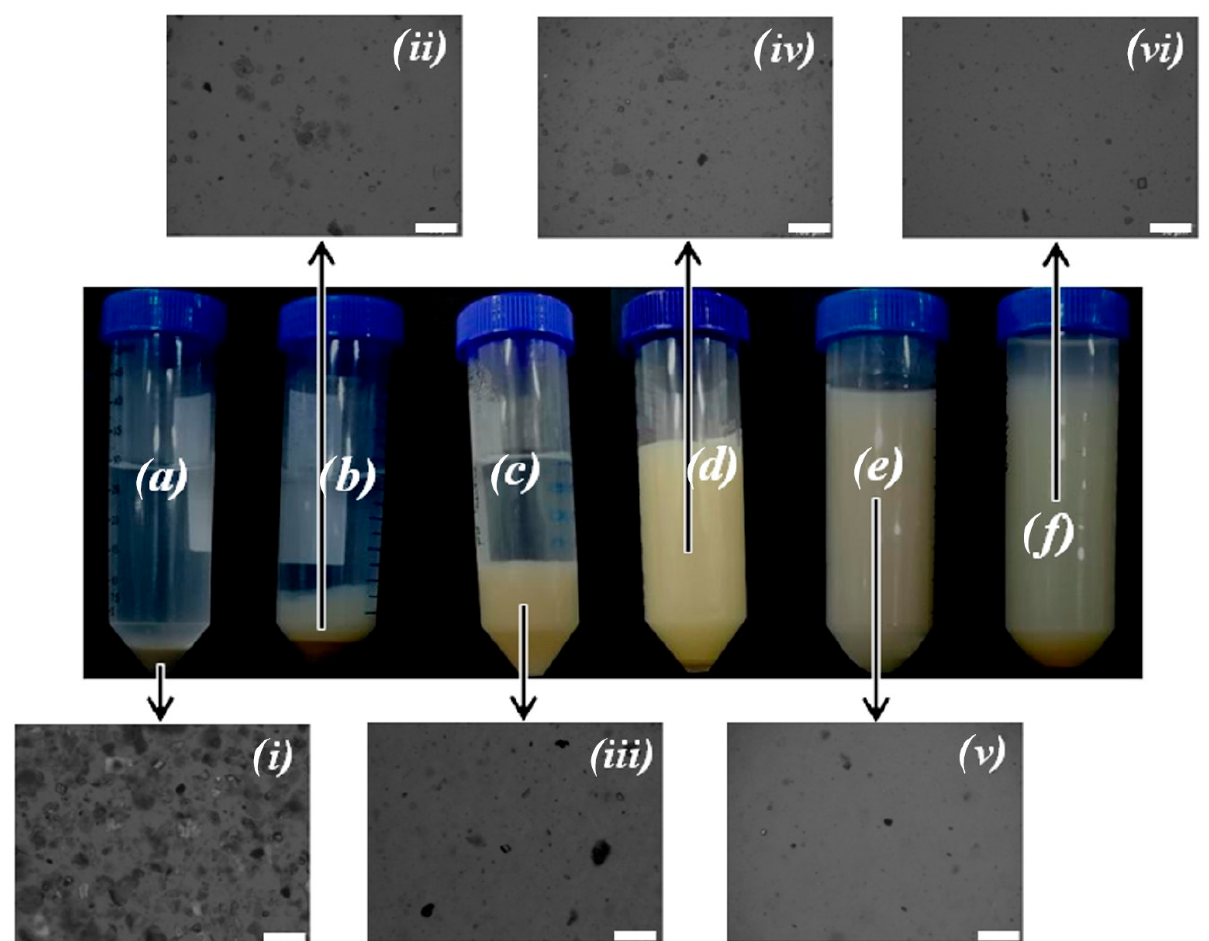
Figure 4. 1.0 wt % palygorskite aqueous suspensions (pH ca. 8). ( a ) Magnetically stirred; ( b ) magnetically stirred with 0.1 wt % polyphosphate; ( c ) high-shear dispersed; ( d ) high-shear dispersed with 0.1 wt % polyphosphate; ( e ) sonicated; ( f ) sonicated with 0.1 wt % polyphosphate. ( i ) Bottom phase of the suspension in ( a ); ( ii ) bottom phase of the suspension in ( b ); ( iii ) bottom phase of the suspension in ( c ); ( iv ) the suspension in ( d ); ( v ) the suspension in ( e ); ( vi ) the suspension in ( f ). The images (photographs and micrographs) were taken 20 days after sample preparation. The scale bar in the insets ( i )–( vi ) represent 100 µm.